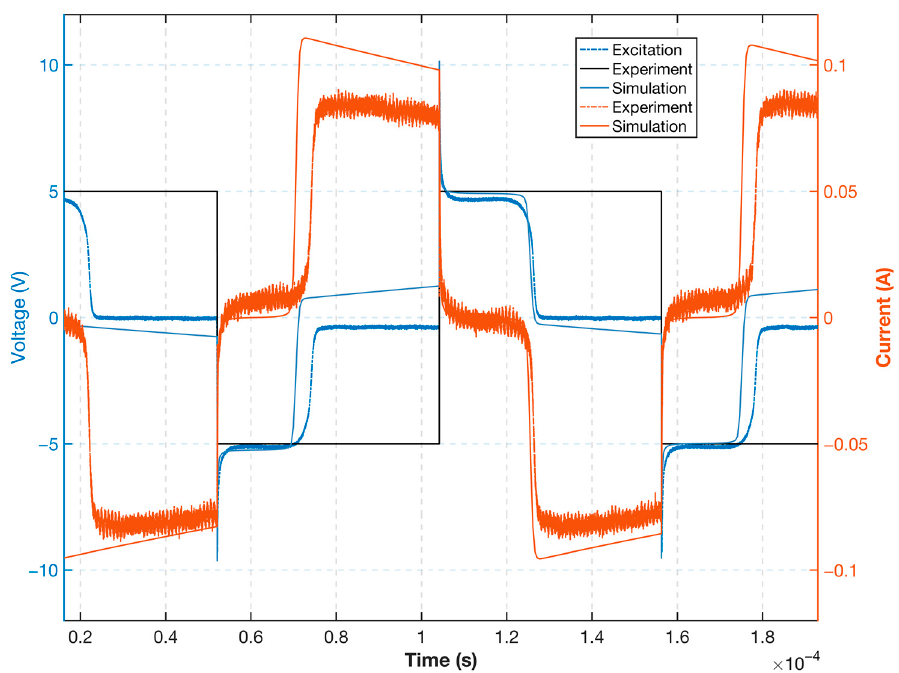
Figure 14. Comparison of simulated and experimental waveforms of a single resistor excitation circuit.